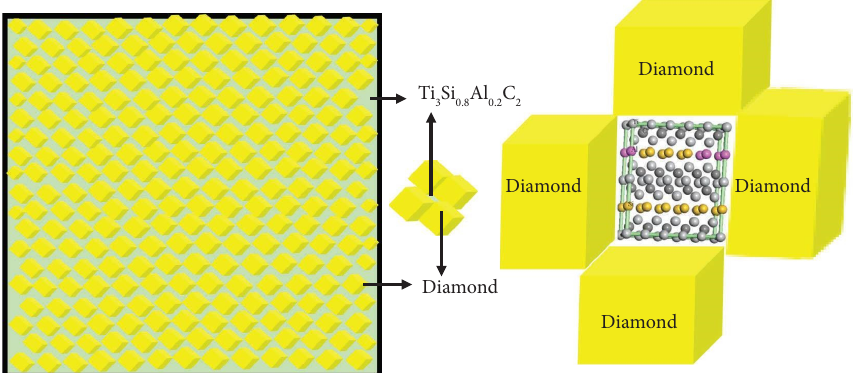
Figure 15: Schematic diagram of the thermal stability of diamond-reinforced Ti